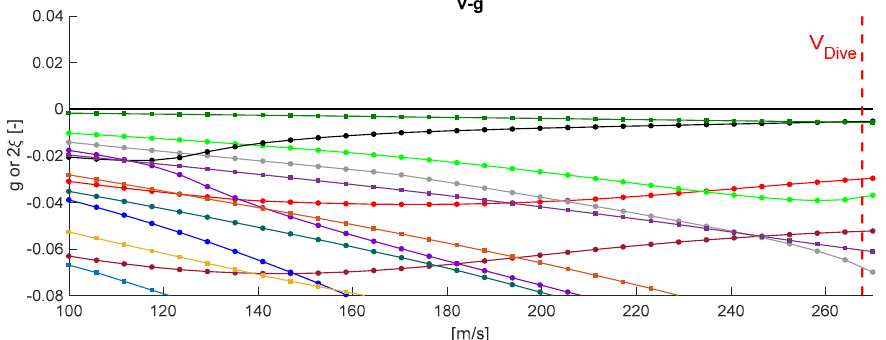
Figure 11. Evolution of the aeroelastic damping vs. TAS for the COMP7 LAM2 Λ = 12.24 at corner point altitude z = 8061 m.